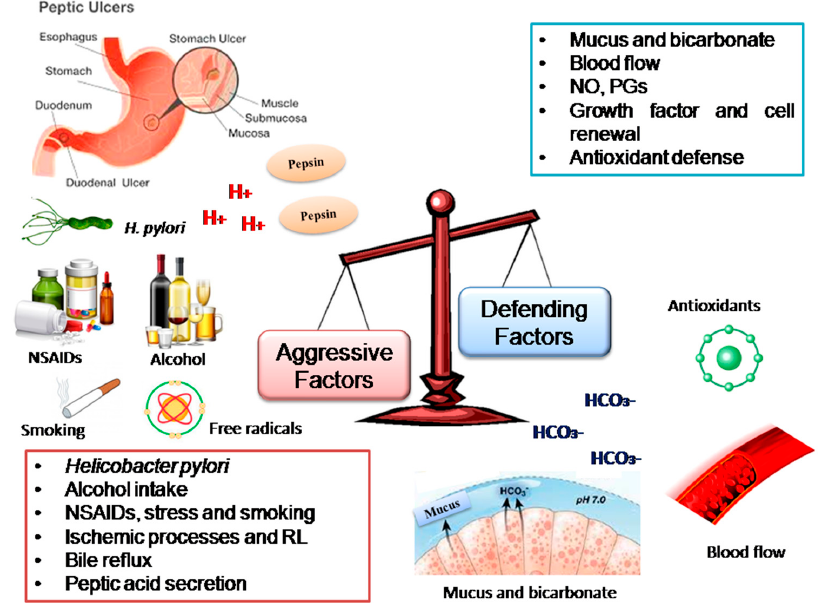
Figure 1. Schematic representation of peptic ulcer etiopathogenesis.